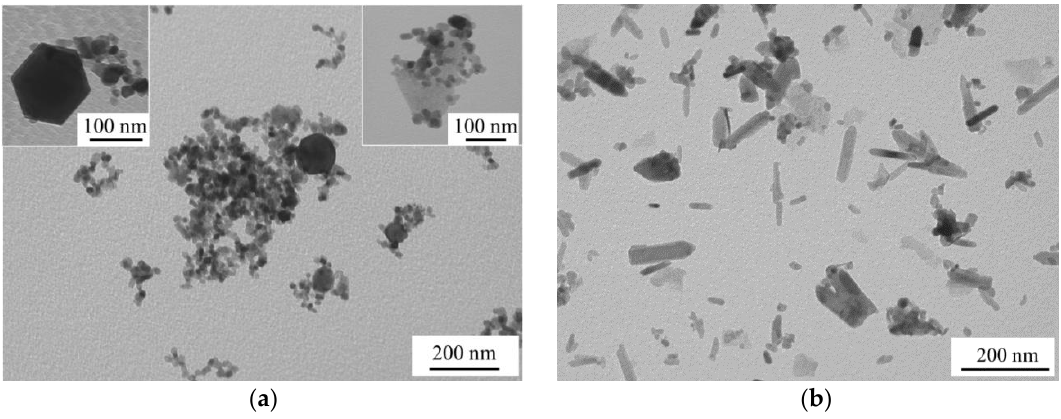
Figure 3. TEM images of samples: ZnO_air ( a ) and ZnO_water ( b ).